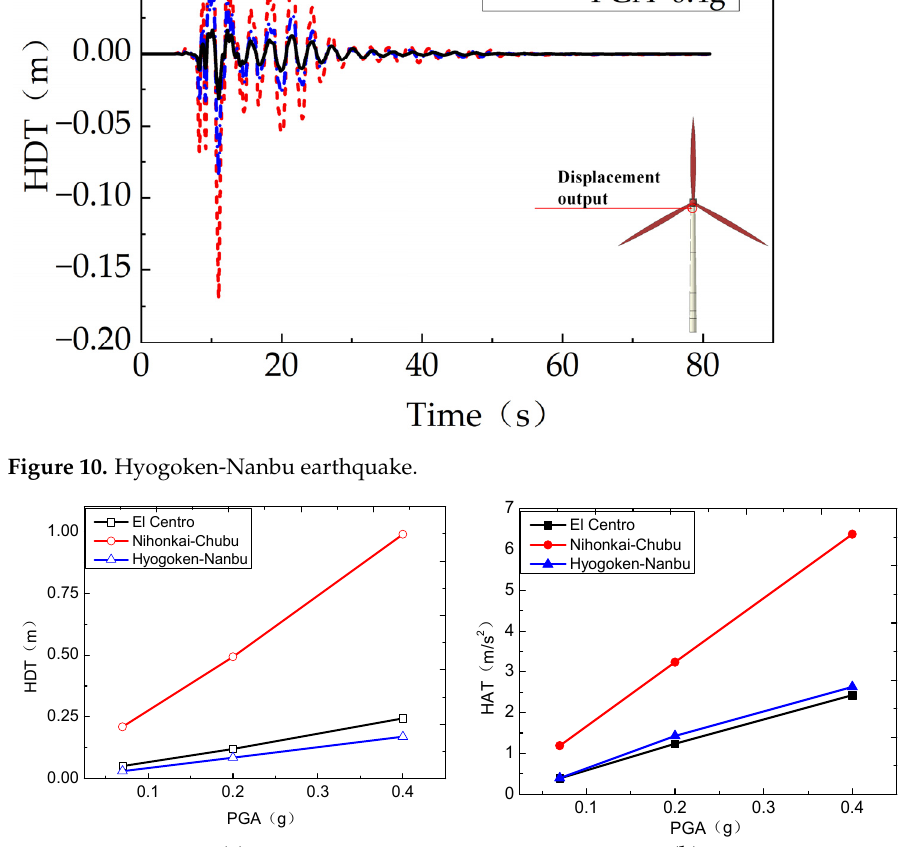
Figure 11. Comparison of dynamic response characteristics of wind turbine tower: ( a ) the maximum displacement; ( b ) the peak acceleration. Table 5. Dynamic response of structures under different seismic records.